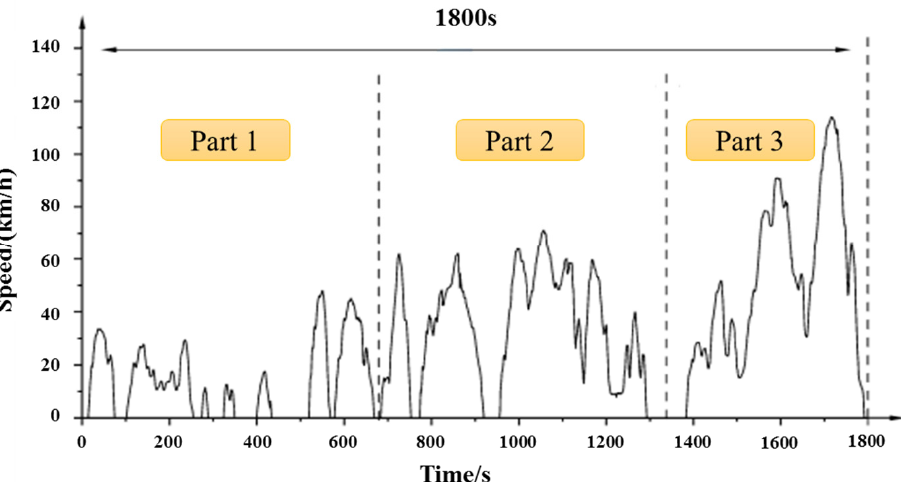
Figure 4. CLTC-P working condition curve.